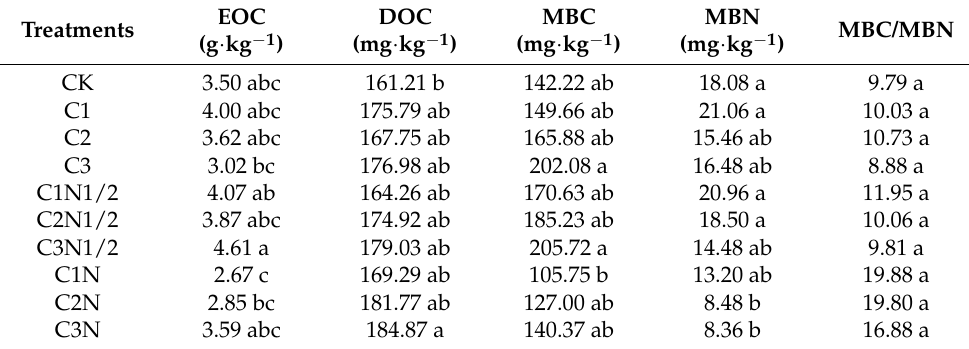
Table 2. Soil active organic carbon fraction under different treatments.